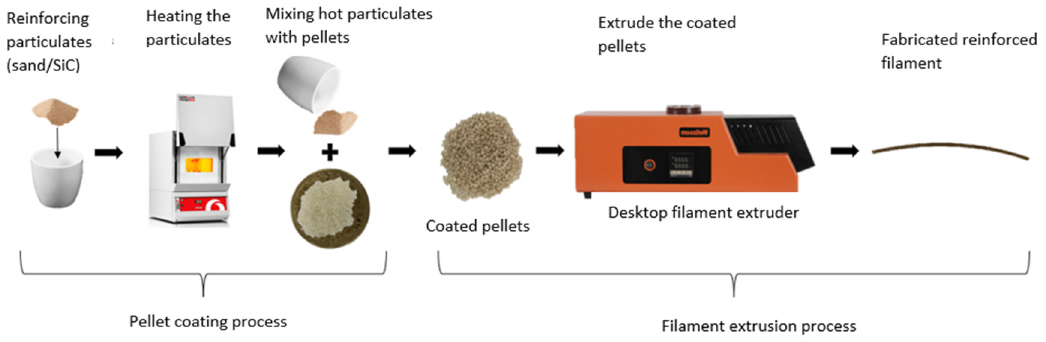
Figure 1. Schematic diagram describing the proposed premixing and extrusion processes.